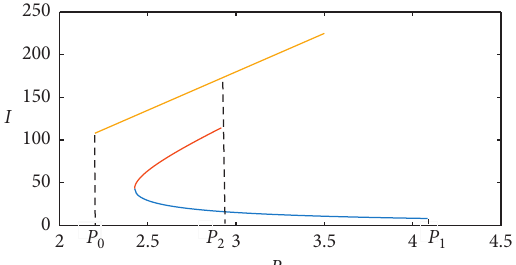
Figure 2: The density of the infected animal populations as a function of basic reproduction number R equilibrium will appear when there is no transport, P that the equilibrium will disappear in the case of transport, and P indicates that there are three equilibria in two cases. Parameter